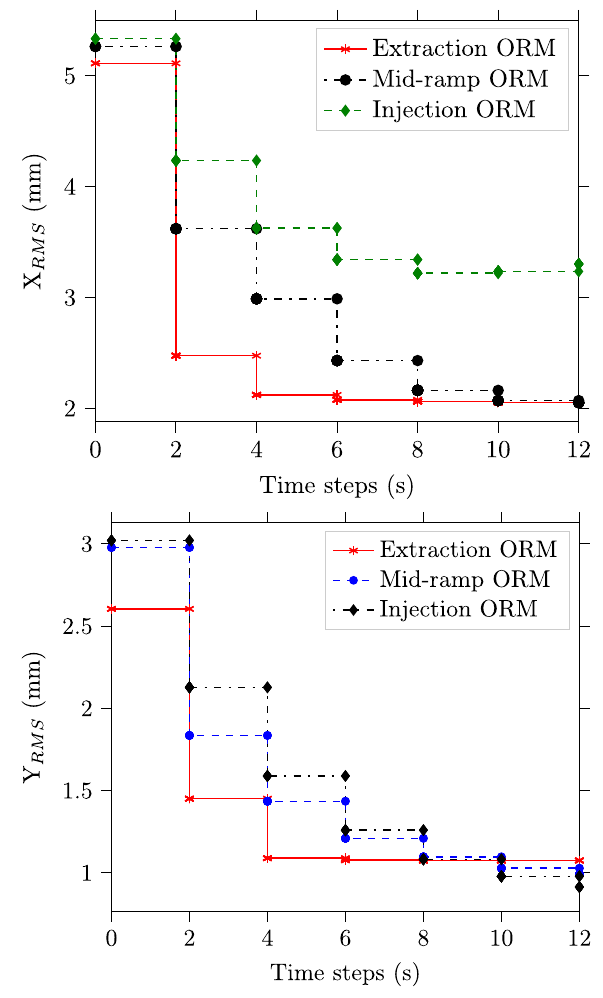
FIG. 13. Measured RMS of the closed orbit in x -plane (top) and in y -plane (bottom) for machine settings corresponding to injection, midramp, and extraction energy while using the ORM corresponding to extraction settings for the corrector settings